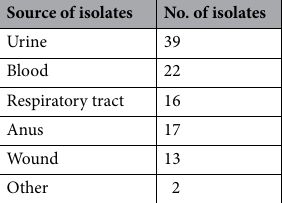
Table 7. K. pneumoniae isolation